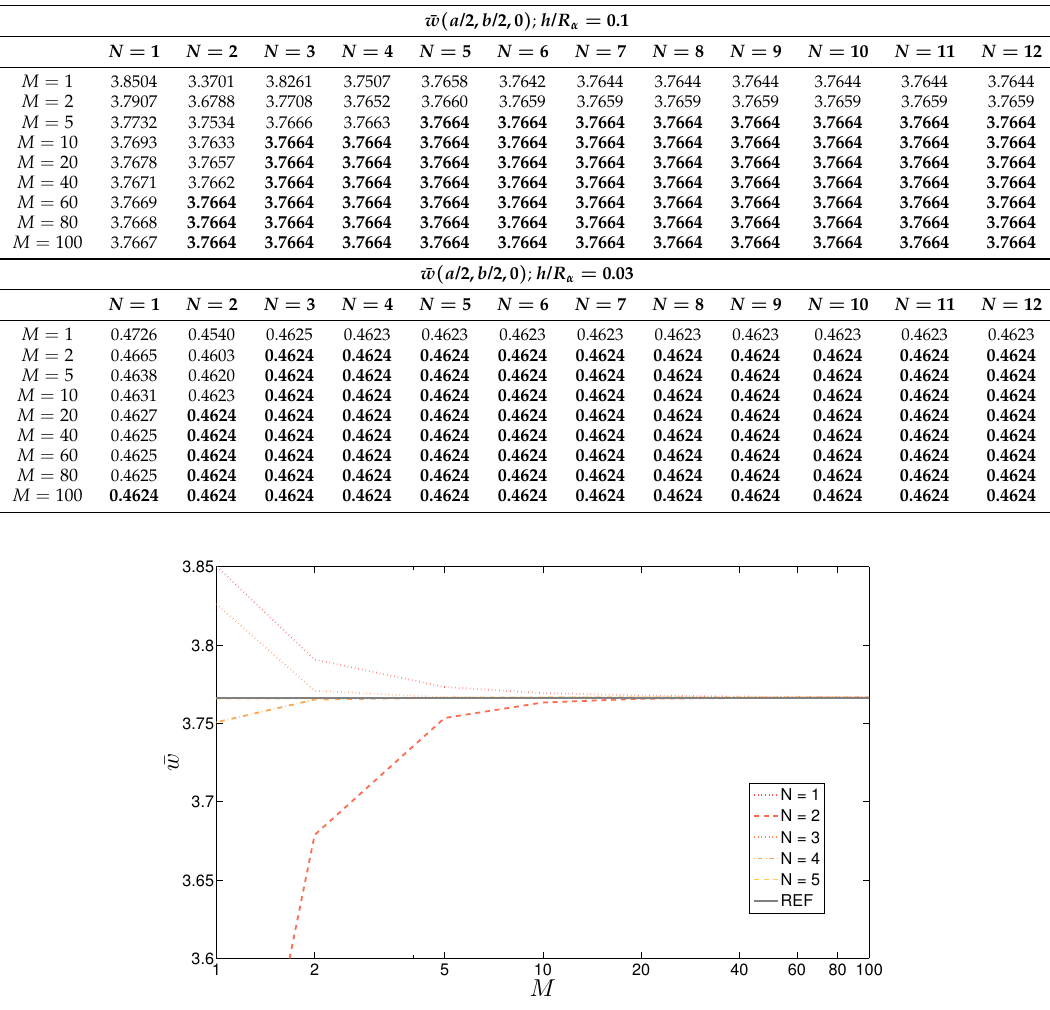
Figure 7. Case 4, simply supported composite laminated spherical shell with thickness ratio h / R α = 0.1. Displacement ¯ w vs. number M of mathematical layers introduced for different orders of expansion N for the exponential matrix. REF means 3D solution by Fan and Zhang